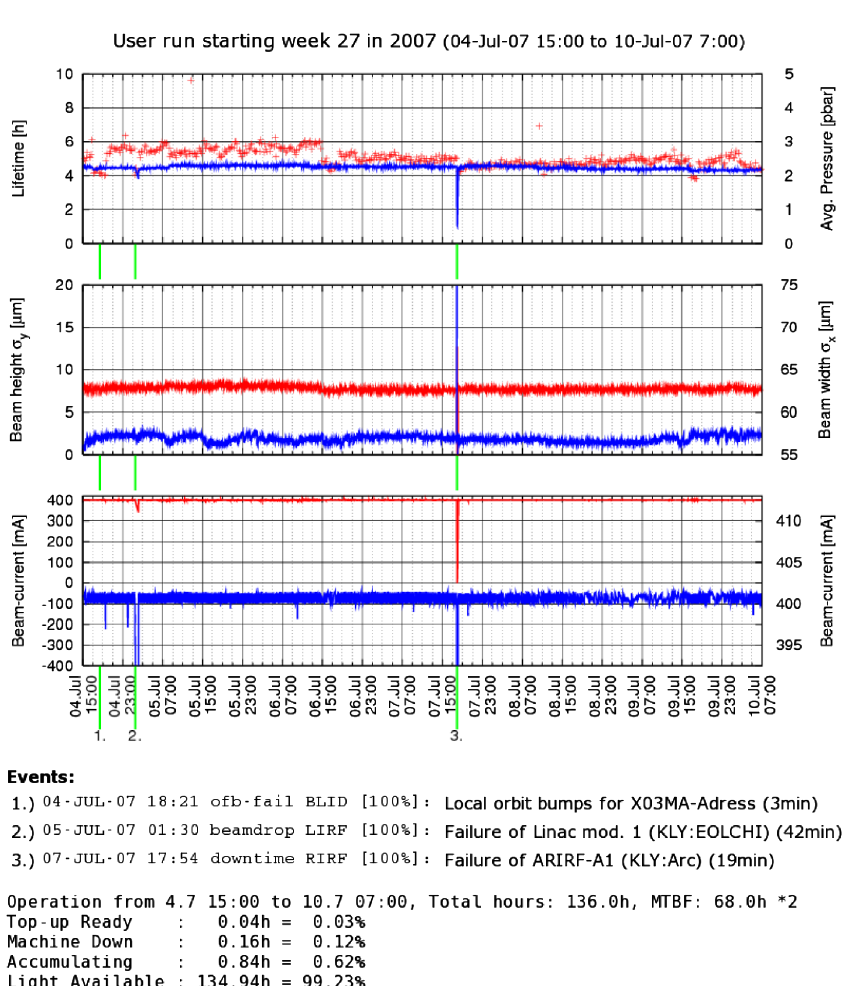
FIG. 7. (Color) User-run overview with events